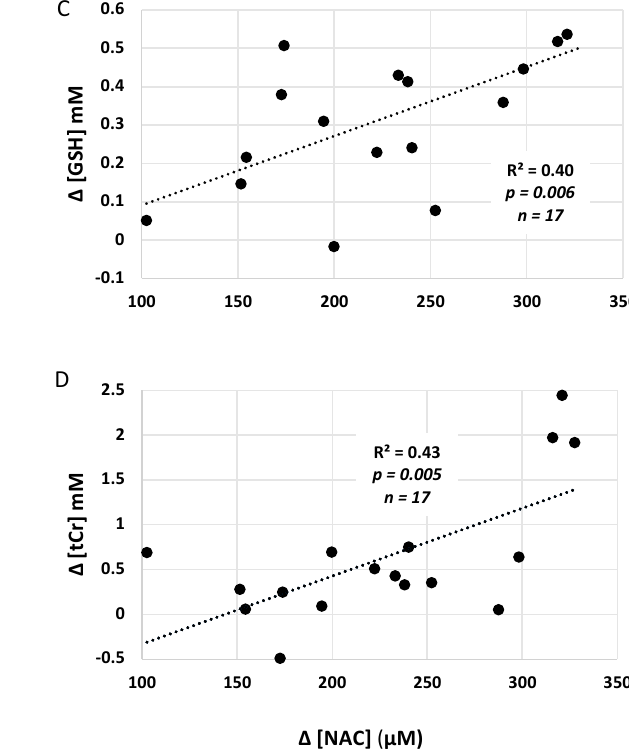
Figure 3. CNS GSH changes over time and by NAC dose. ( A ) [GSH] in BG of the 10 HIE infants with serial MRS on DOL 5–6 immediately before (trough = 0 h), and after NVD (peak = 12–30 min) and delayed (post-peak = 2–6 h), with NAC alone ( n = 5) or NVD infusion ( n = 5). ( B ) [GSH] change with NAC 25 mg/kg/dose or 40 mg/kg/dose from trough to peak [GSH] or peak to post-peak (2–6 h) after NAC/NVD infusion (* p < 0.05). We included all patients who had the entire dose reliably delivered prior to second scan (efficacy analysis). ( C , D ) Trough to peak increase in plasma [NAC] plotted with the simultaneous increase in basal ganglia metabolites ( C ) [GSH] and ( D ) [tCR] for the 17 subjects with adequate MRS and [NAC] plasma data.